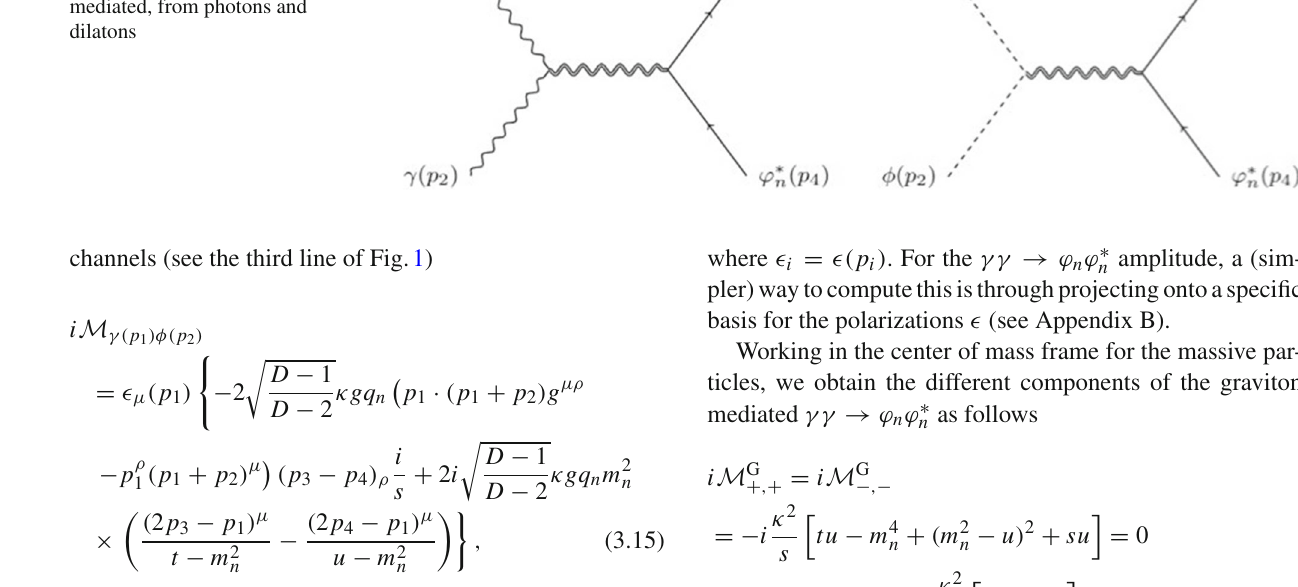
Fig. 2 Feynman diagrams for pair production, gravitationally mediated, from photons and dilatons